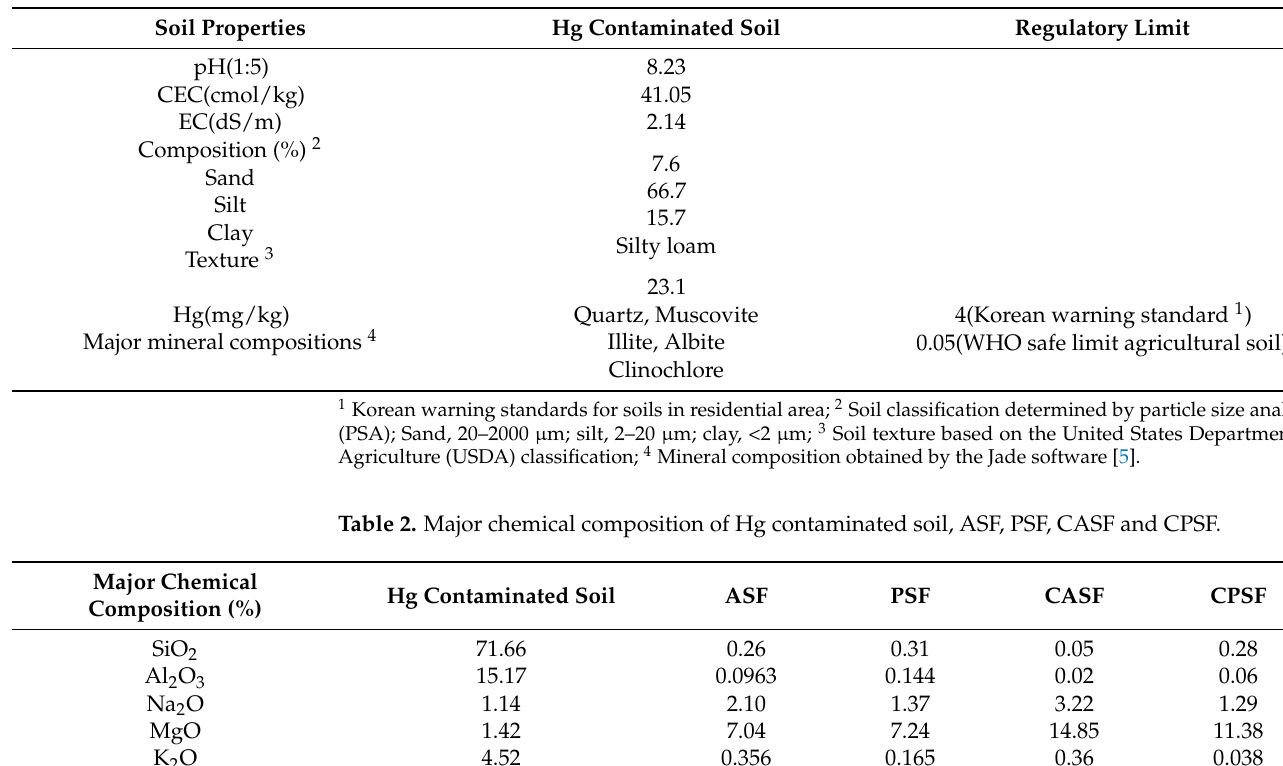
Table 1. Contaminated soil characterization results.